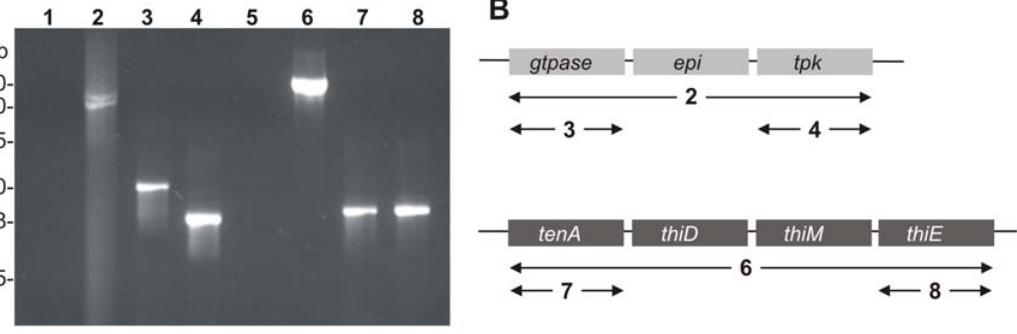
Figure 1. Reverse transcriptase (RT-) PCR on total S.aureus RNA. RT-PCR was carried out to evaluate whether the open reading frames of the S.aureus vitamin B1 metabolism are clustered and thereby suggested to be organized in operons. (A) Amplification of the cluster consisting of the ORFs gtpase , epi and tpk using the primers Sa GTPase-IBA3-S and Sa TPK-IBA3-AS (lane 2); as controls, the PCR was either carried out without RT step (lane 1) or amplification of the flanking ORFs was performed with the primers Sa GTPase-IBA3-S and Sa GTPase-IBA3-AS (lane 3) and Sa TPK-IBA3-S and Sa TPK-IBA3-AS (lane 4). The ORFs of the operon consisting of tenA , thiM , thiD and thiE were amplified using the primers Sa TenA-IBA3-S and Sa ThiE-IBA3-AS (lane 6). As controls the PCR was carried out without RT step (lane 5) and amplification of the flanking open reading frames was performed either with the primer Sa TenA-IBA3-S and Sa TenA-IBA3-AS (lane 7) or the primer Sa ThiE-IBA3-S and Sa ThiE-IBA3-AS (lane 8). (B) The organisation of the proposed operons is schematically illustrated. Note: Numbering of figure 1B refers to the respective lane number of figure 1A.